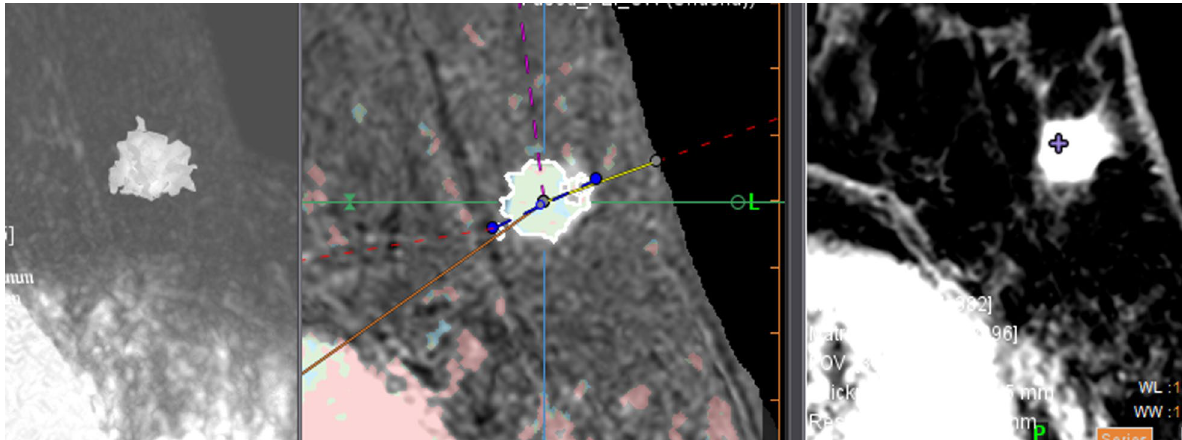
Fig. 2 Example of semi-automated segmentation in the axial plane for a grade II infiltrating carcinoma of the left breast on dynamic contrast enhancement subtraction with MIP reconstruction; dynamic contrast enhancement sequence merged with the PEI map; and dynamic contrast enhancement without subtraction